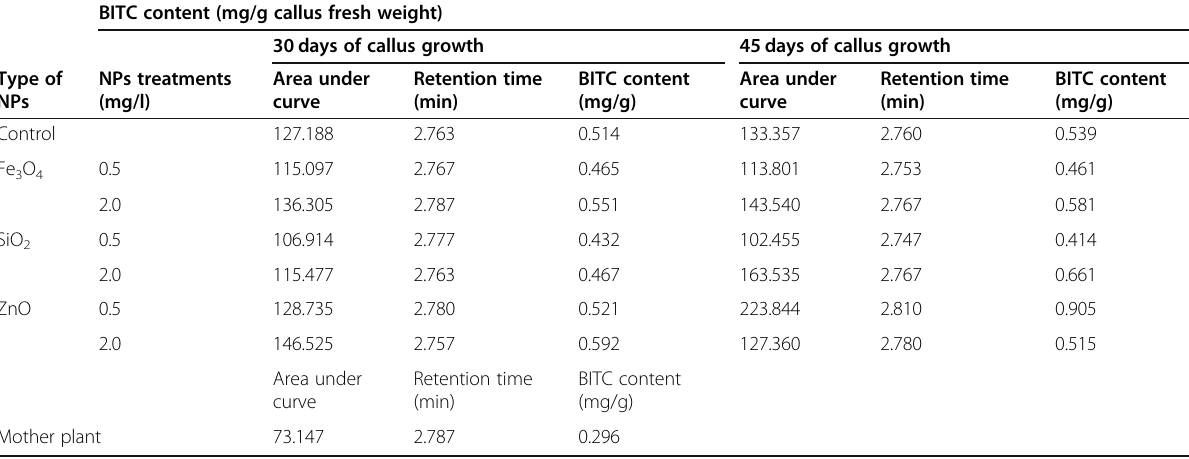
Table 2 Effect of nanoparticles on benzyl isothiocyanate content in Salvadora persica callus after 30 and 45 days of treatment BITC content (mg/g callus fresh weight) 30 days of callus growth 45 days of callus growth Type of